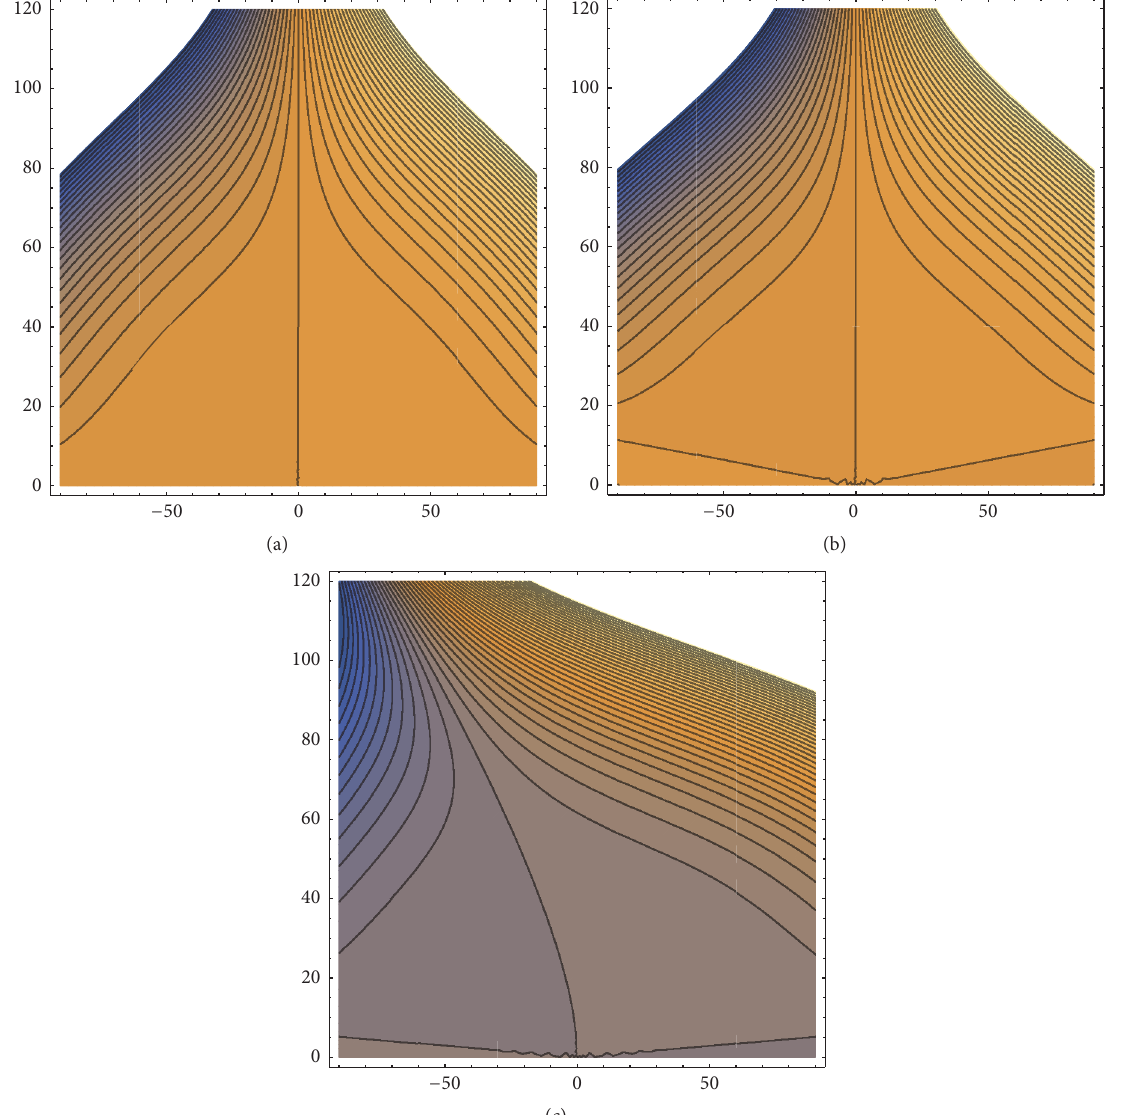
Figure 1: The figures are made, respectively, with (𝜖 = 1 , 0, − 1 ) with fixed parameter V 0 = 0.02 and unitary value for mass and charge with 50 contour lines in the ranges 𝑟[−90,90] and 𝑧[0, 120] .